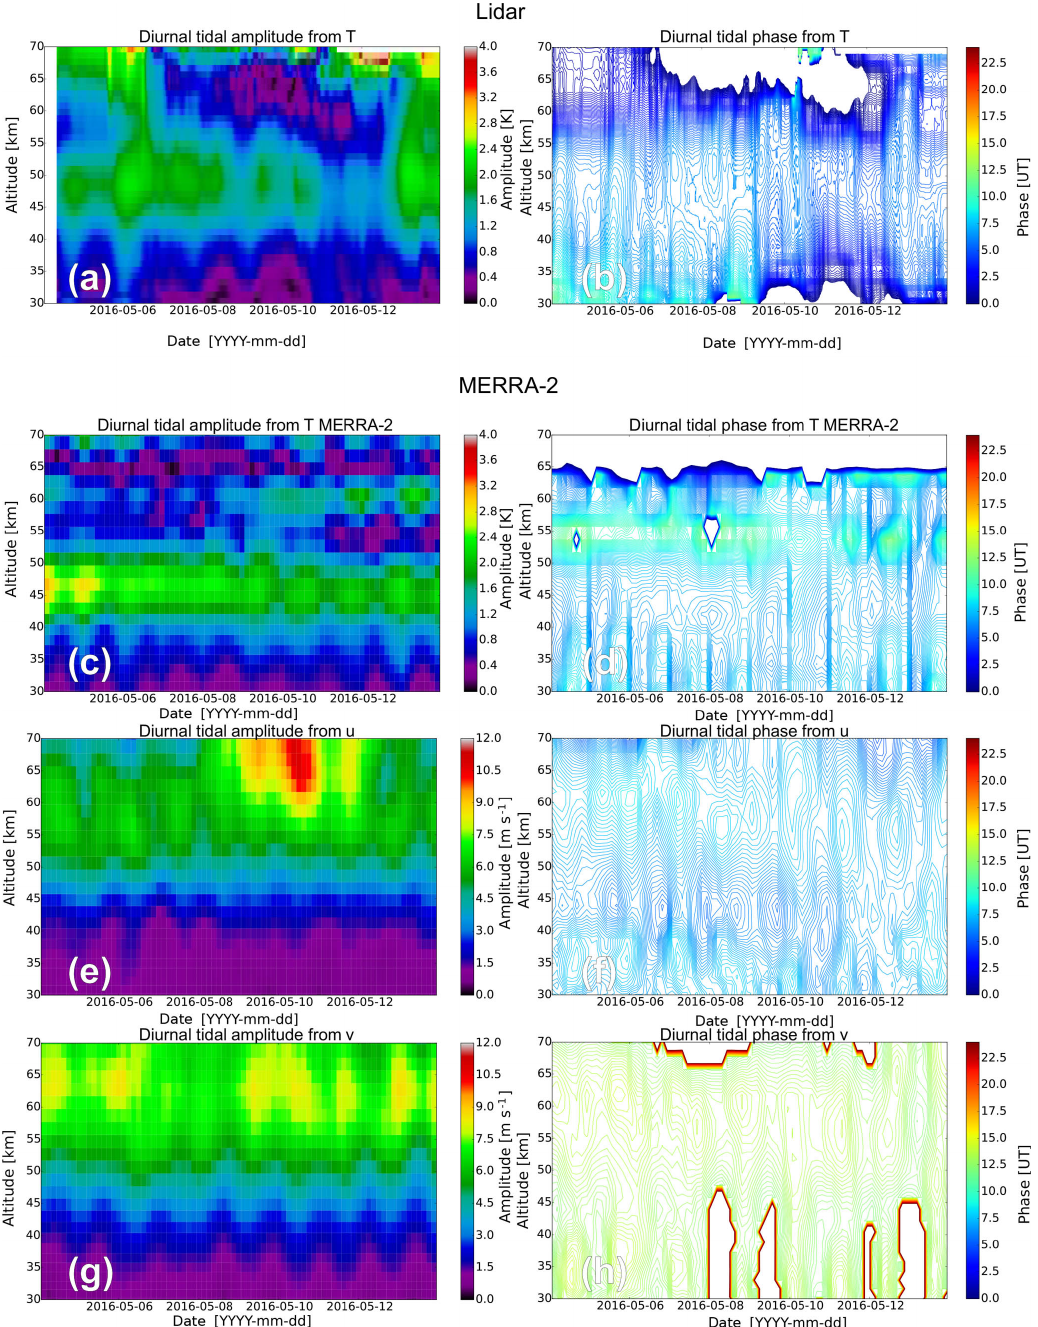
Figure 7. Comparison of the time-resolved diurnal tidal amplitudes (a, c, e, g) and phases (b, d, f, h) derived from the lidar and MERRA-2 temperature field and the MERRA-2 zonal and meridional wind field in May